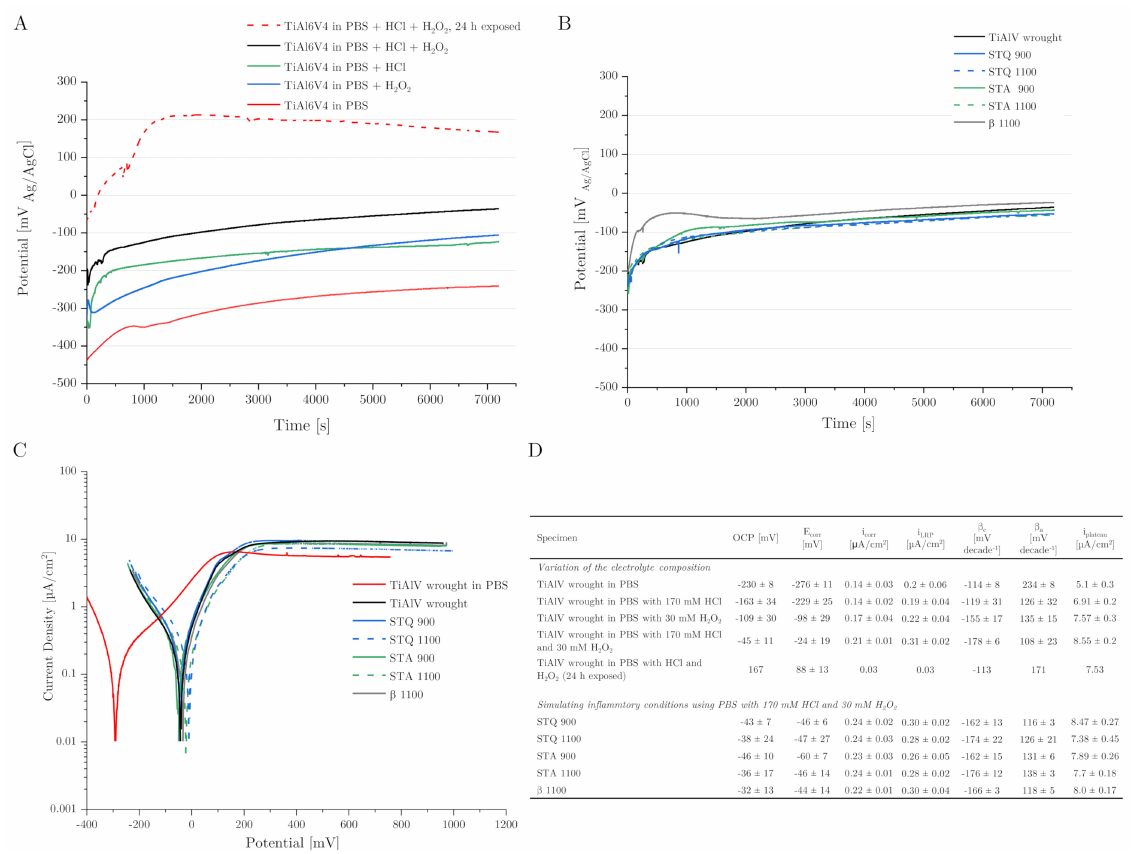
Figure 6. Results of the electrochemical corrosion tests measured against the Ag/AgCl reference electrode. ( A ) Comparison of the electrolyte composition with different additives on OCP of TiAl6V4 wrought alloy. The curves demonstrate the oxidation capacity of HCl and H 2 O 2 simulating inflam- matory conditions. ( B ) OCP measurements of different heat-treated TiAl6V4 conditions in PBS with 170 mM of HCl and 30 mM of H 2 O 2 immersion for 2 h at room temperature. ( C ) Polarization curves of all tested samples under simulated inflammatory conditions (PBS with 170 mM of HCl and 30 mM of H 2 O 2 ). ( D ) Results of the experimental values: OCP (last 300 s), corrosion potential (E corr ), corro- sion current densities according to Tafel extrapolation (i corr ) or linear polarization resistance (i LRP ) using the cathodic ( β c ) and anodic ( β a ) Tafel coefficient and high-potential plateau current densities (i plateau ) of the TiAl6V4 wrought condition in pure PBS, with additives of 170 mM of HCl and 30 mM of H 2 O 2 and of the heat-treated TiAl6V4 samples under simulated inflammatory conditions using PBS with HCl and H 2 O 2 (data as mean ± SD, n =